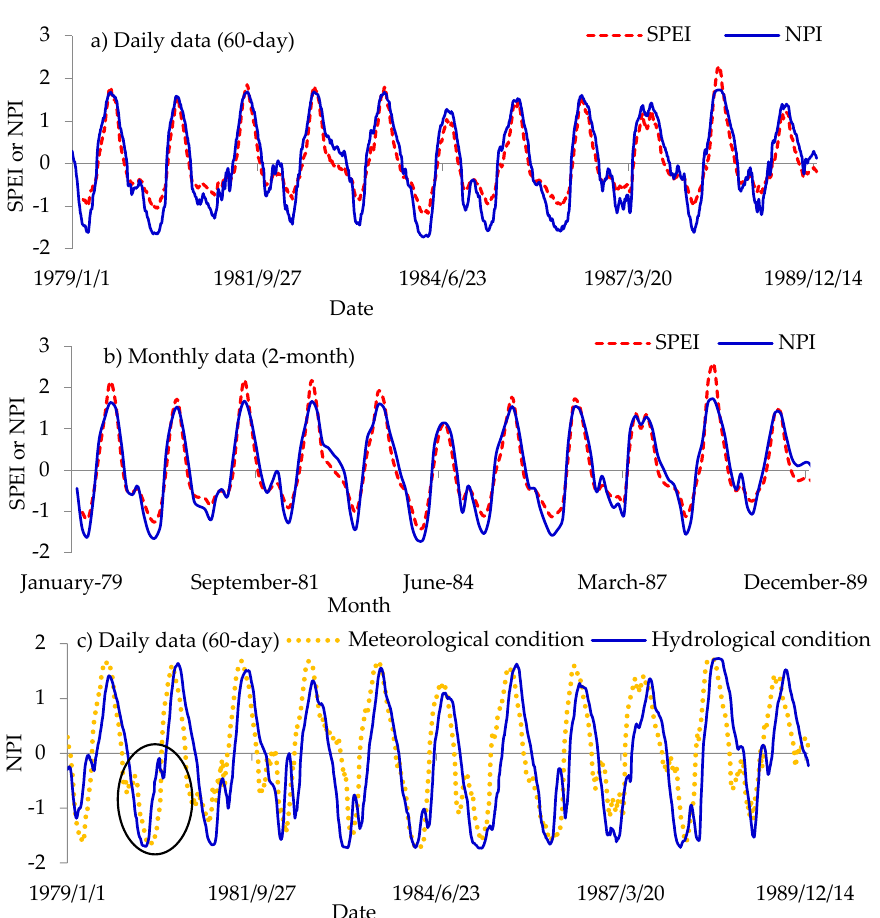
Figure 9. Meteorological dry and wet conditions in terms of NPI and SPEI applied to catchment-wide: ( a ) daily; and ( b ) monthly precipitation insufficiency. Chart ( c ) shows NPI derived from daily river flow ( H ) and precipitation insufficiency ( H ). In each chart, the label text in “( )” shows the aggregation level.